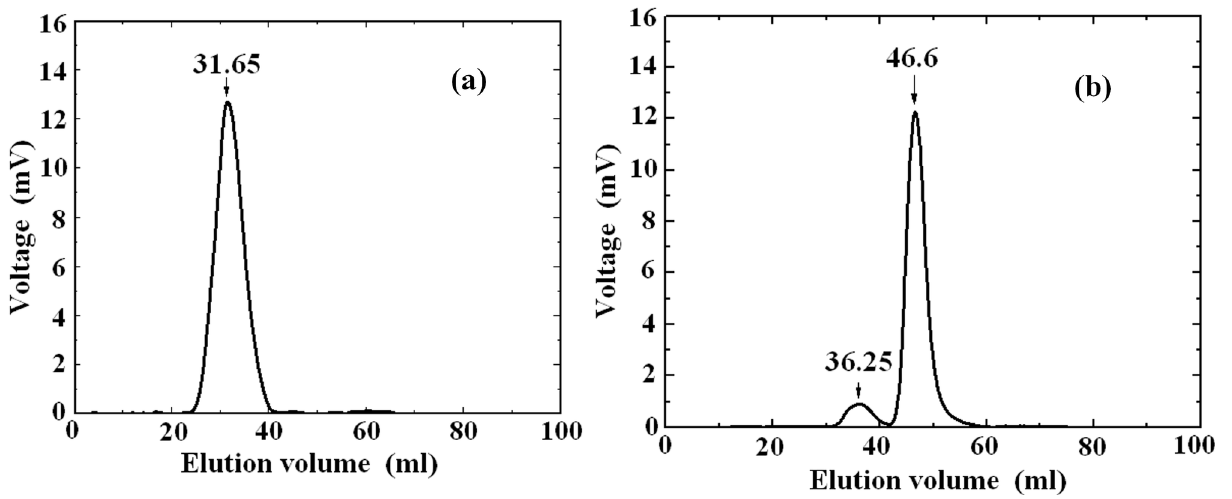
Figure 2. The elution profiles of the hemoglobin solutions (a) at pH 7.4 and (b) at pH 5.4. doi: